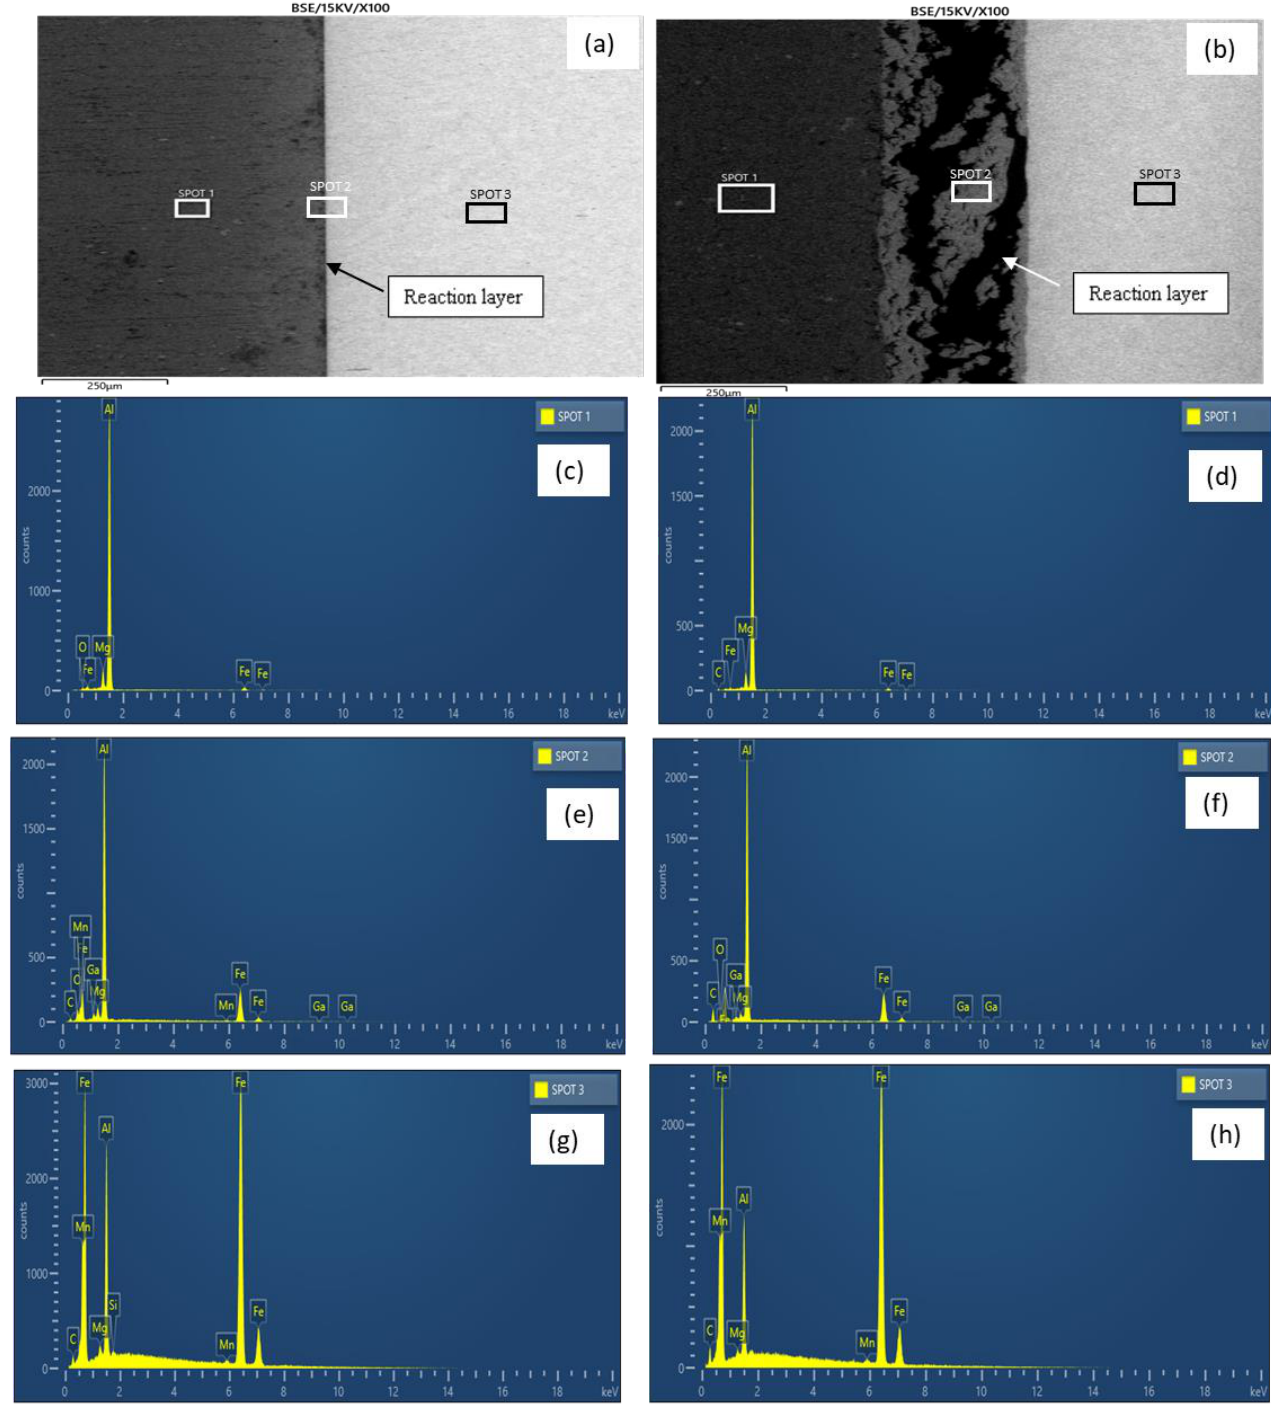
Figure 5. ( a ) Micrograph of sample H; ( b ) Micrograph of sample E; ( c ) Sample H EDX analysis (spot 1); ( d ) Sample E EDX analysis (spot 1); ( e ) Sample H EDX analysis (spot 2); ( f ) Sample E EDX analysis (spot 2); ( g ) sample H EDX analysis (spot 3); ( h ) sample E EDX analysis (spot 3).